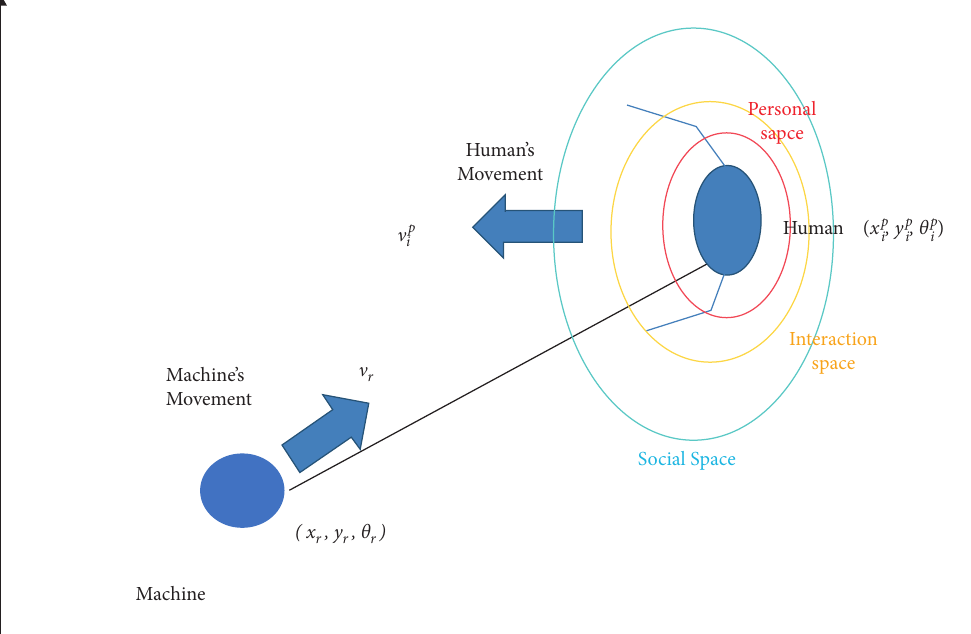
Figure 14: Relative constraints between a human and machine.